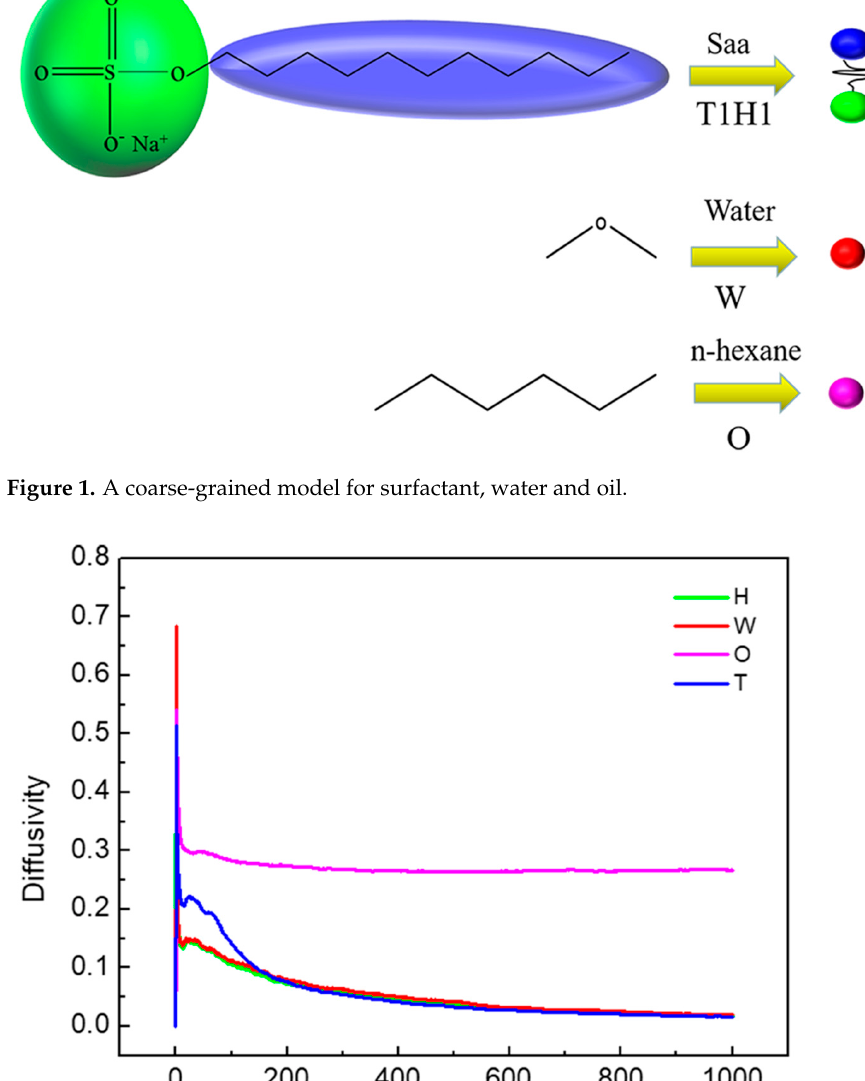
Figure 1. A coarse ‐ grained model for surfactant, water and oil.